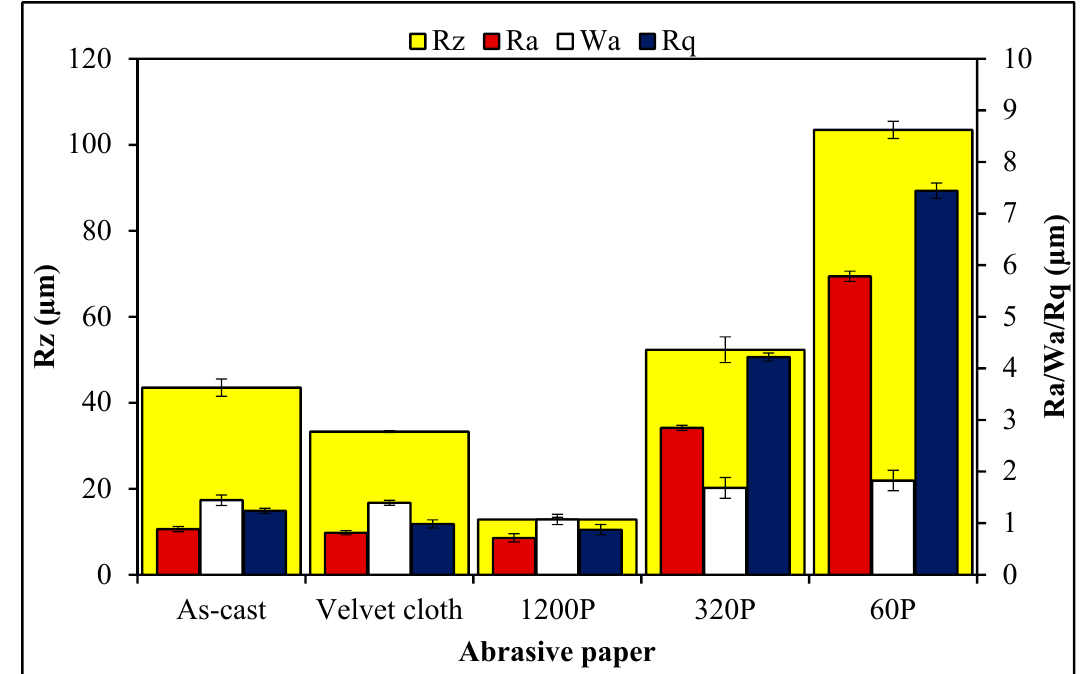
Figure 5. Topographical features of 0.1 wt % MLG-EP nanocomposites.